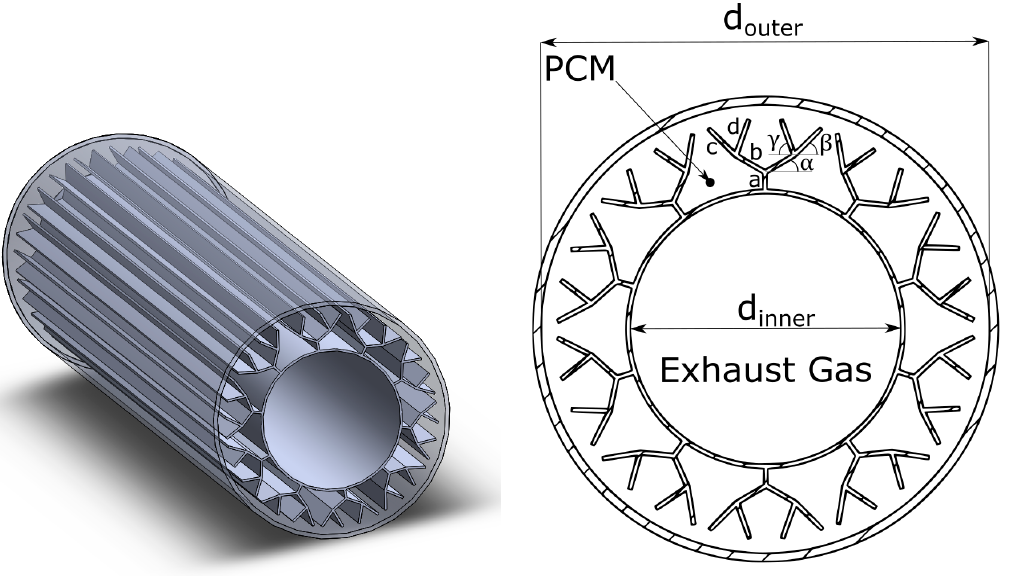
Figure 4. TESS geometry.